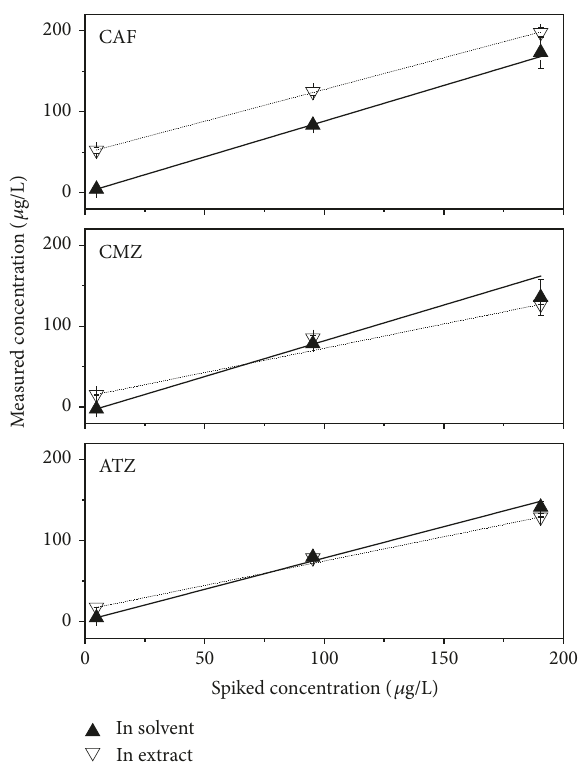
Figure 2: Matrix effects on the analytical response of the investi- gated